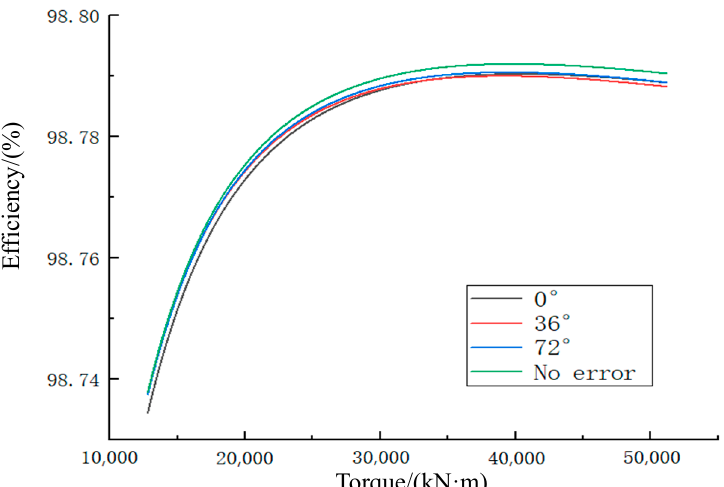
Figure 9. Influence of load-sharing coefficient on gear train efficiency.